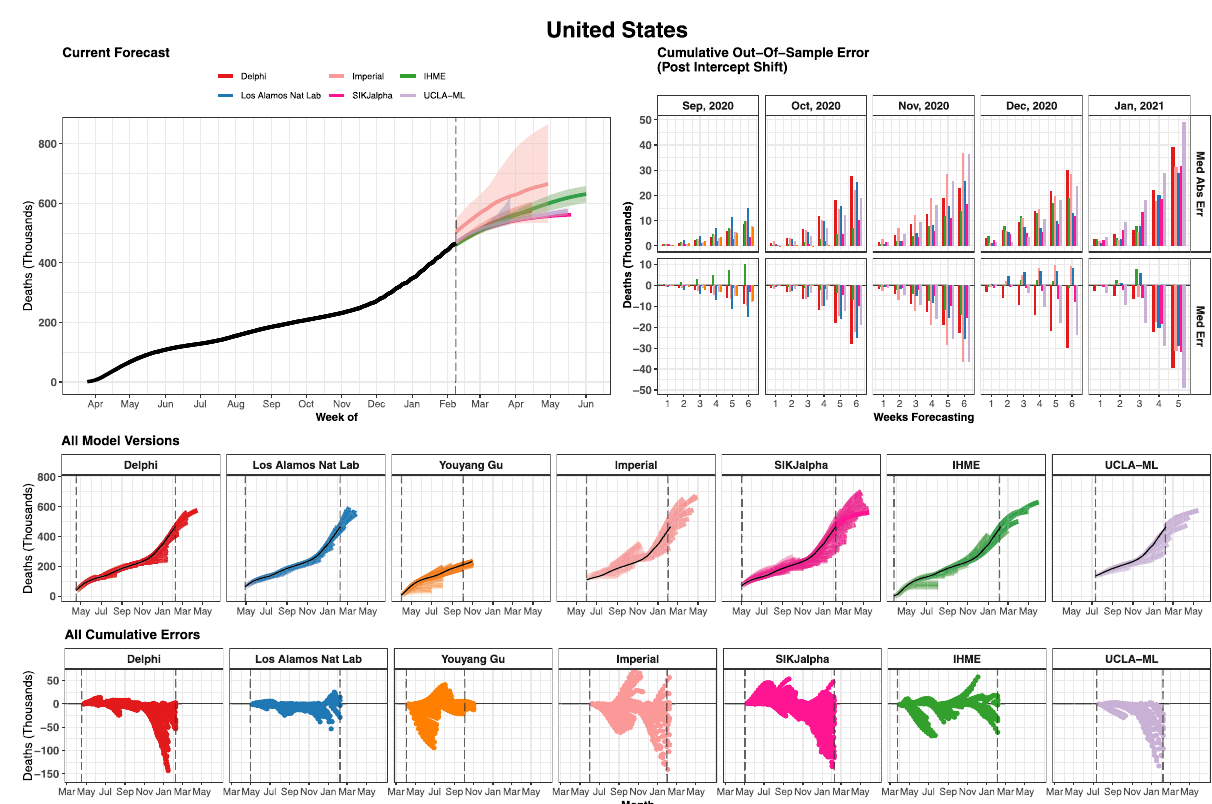
Fig. 1 Cumulative mortality forecasts and prediction errors by model — example for the United States. The most recent version of each model is shown on the top left, as well as 95% prediction intervals when available. The middle row shows all iterations of each model as separate lines. The vertical dashed lines indicate the fi rst and last model release date for each model. The bottom row shows all errors calculated at weekly intervals (circles). The top right panel summarises all observed errors, using median error (top) and median absolute error (bottom), by weeks of forecasting and month of model estimation. Errors incorporate an intercept shift to account for differences in each model ’ s input data. This fi gure represents an example for the United States of country-speci fi c plots made for all locations examined in this study. Graphs for all geographies can be found in the Supplementary Information. Note that while certain models use different input data source than the other modelling groups causing apparently discordant past trends in the top-left panel. We plot raw estimates on the top-left panel; however, we implement an intercept shift to account for this issue in the calculation of errors. Delphi DELPHI-MIT (red), Los Alamos Nat Lab Los Alamos National Laboratory (blue), Youyang Gu (orange), Imperial Imperial College London (peach), SIKjalpha USC SIKJ-alpha (pink), IHME Institute for Health Metrics and Evaluation (green), UCLA-ML UCLA Statistical Machine Learning Lab